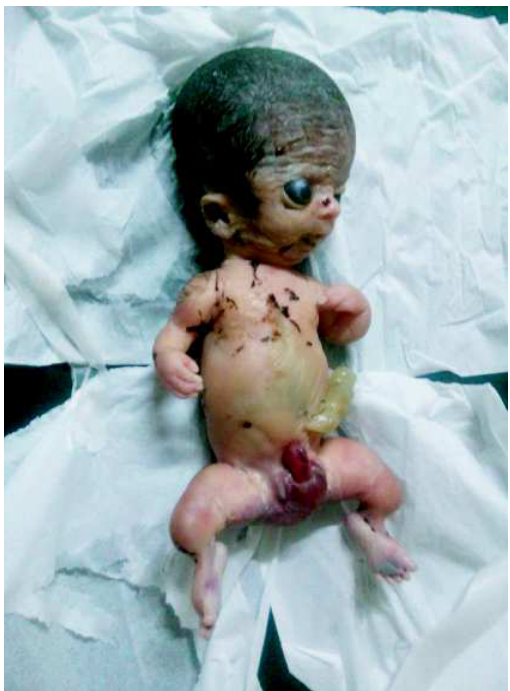
Fig 3. Babygram showing rhizomelic appearance with metaphyseal flaring of limbs, hypoplastic iliac bones, narrow chest with short horizontal ribs, relative macrocephaly and platyspondyly (flattening of vertebral bodies) Fig 4. The baby just after